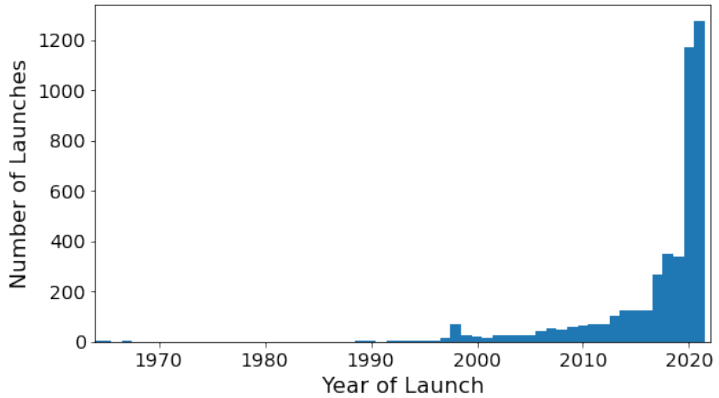
Figure 1. Number of launches per year for currently active satellites [28]. X-axis corresponds to the year of launch for a given satellite and Y-axis corresponds to the number of currently active satellites